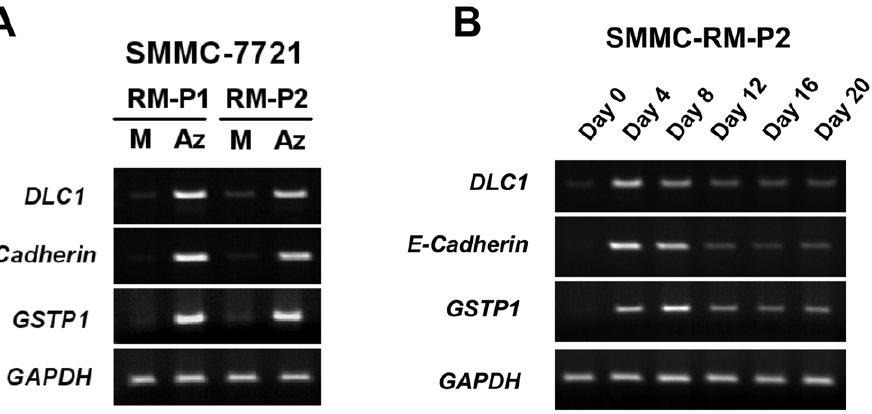
Figure 3. 5-Aza-dC-recovered cells were sensitive to 5-Aza-dC induced derepression. To exclude the potential artifact of DNA re- methylation caused by 5-Aza-dC-resistant cells, two 5-Aza-dC-recovered sub-lines (SMMC-7721 RM-P1 and P2) were established from pooled 5-Aza- dC-recovered population of SMMC-7721. (A) The expression of re-methylated tumor suppressor genes, DLC1 , E-Cadherin and GSTP1 , could successfully be activated once again in these recovered cells by re-administration of 5-Aza-dC. M, Mock; Az, 5-Aza-dC. (B) 5-Aza-dC-recovered cells retained the ability to re-silence DLC1 after being released from 5-Aza-dC treatment. These data indicate that 5-Aza-dC-recovered cells remained sensitive to 5-aza-dC-induced derepression and re-silencing Thus, ruled out the possibility of growth selection artifact caused by the expansion of 5- Aza-dC-resistant sub-populations.